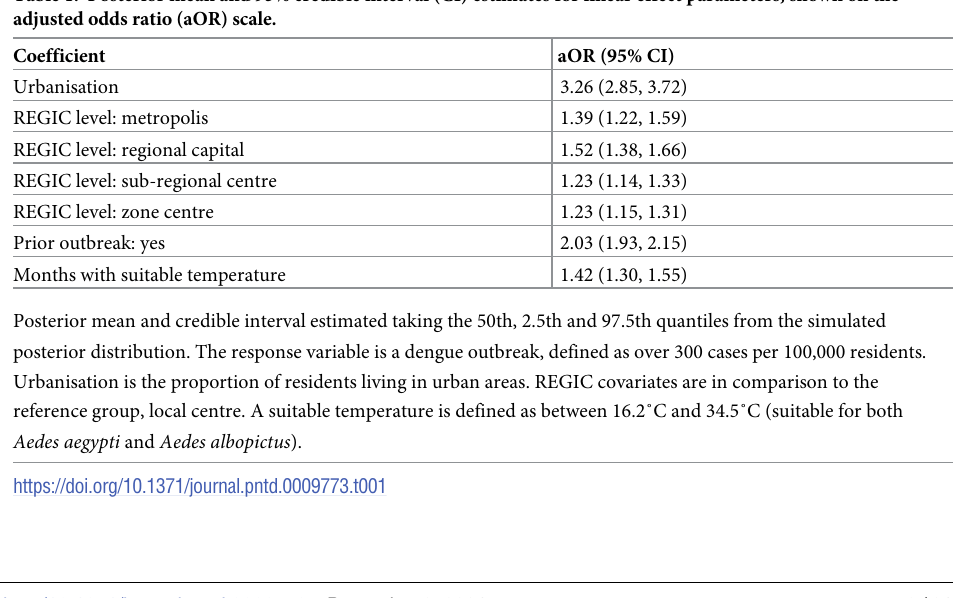
Table 1. Posterior mean and 95% credible interval (CI) estimates for linear effect parameters, shown on the adjusted odds ratio (aOR) scale.